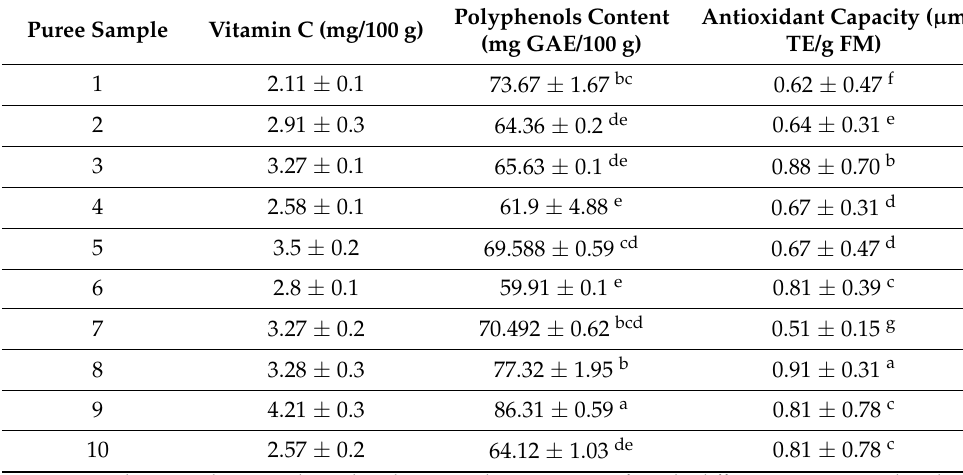
Table 4. Vit. C, TPC and AC determination in unsterilized product.